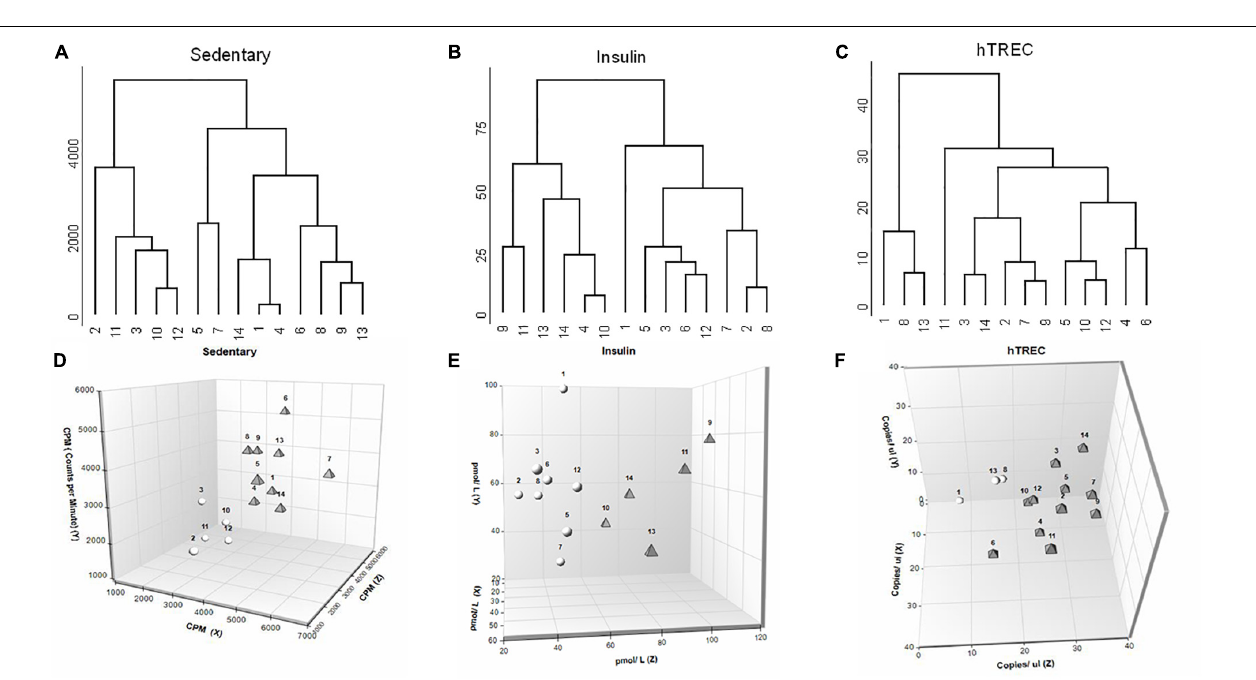
FIGURE 4 | Artificial neural network (ANN) analysis of physiological and molecular parameters in response to lifestyle program. Heat map shows pairwise correlation efficiencies of physiological and molecular parameters ( n = 14). Red color shows high correlation, green color indicates low correlation efficiency between parameters. Significance level of pairwise sensitivity correlation is shown by asterisks ( ∗ p < 0.05, ∗∗ p < 0.01, ∗∗∗ p < 0.001, and ∗∗∗∗ p < 0. 0001). Significance was determined using simple t -test. Mean squared error in last column indicates model accuracy.